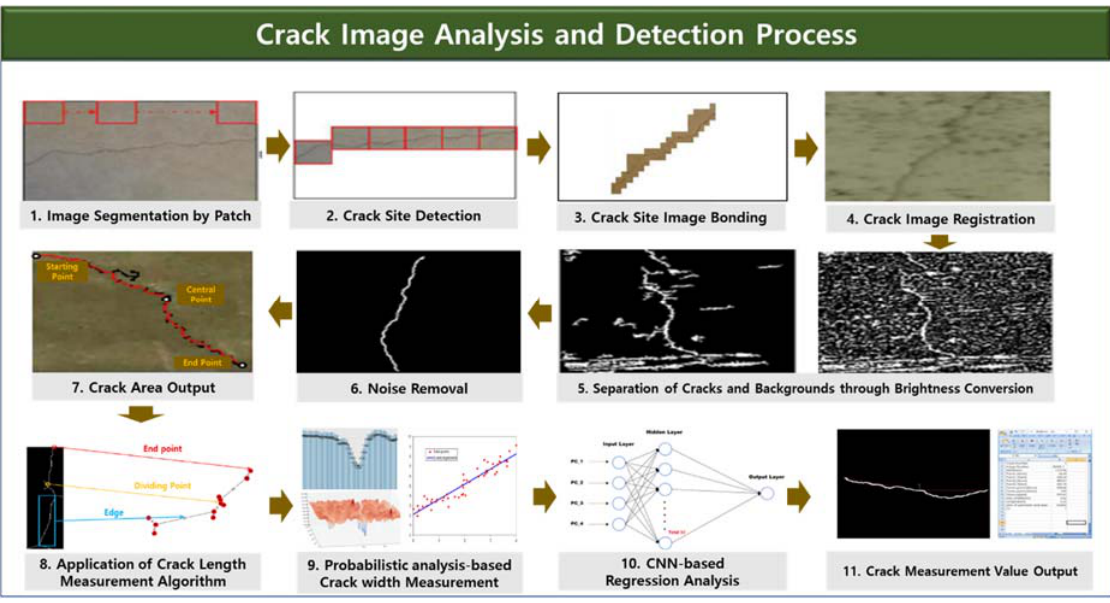
Figure 10. CNN ‐ based Crack Image Analysis and Detection